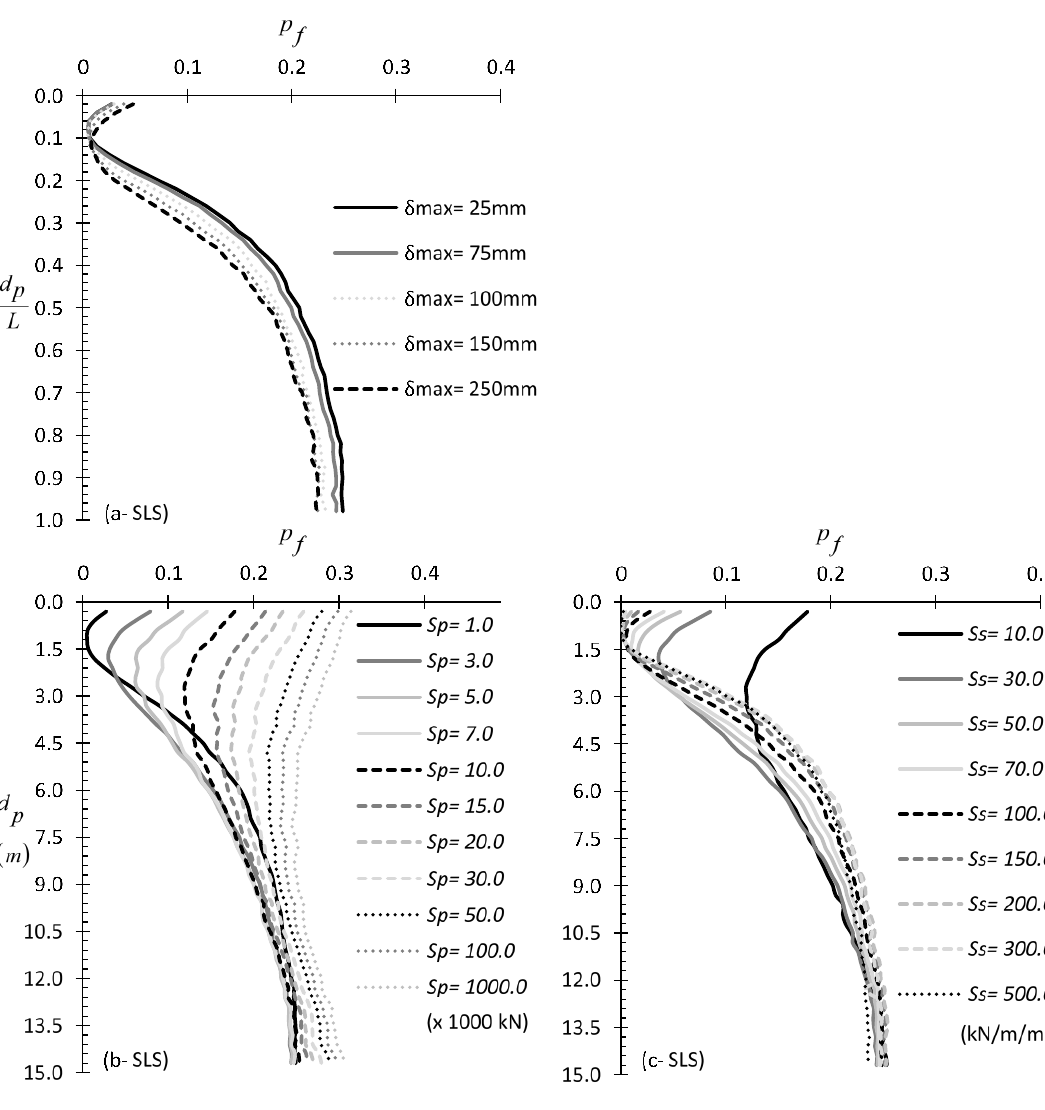
Figure 5. ( a ) p f vs. d p / L curves for the SLS state by considering di ff erent δ max values, ( b ) p f vs. d p d L curves for the SLS state by considering different Figure 5. ( a ) f p vs. p curves for di ff erent mean pile sti ff ness ( S p ) values for the SLS state, and ( c ) p f vs. d p curves for di ff erent d curves for different mean pile stiffness ( S ) values for the SLS state, and ( c ) vs. soil sti ff ness ( S s ) values for the SLS state; figures refer to scaled correlation length θ / L = 2 / p p   S values for the SLS state; figures refer to scaled correlation curves for different soil stiffness s length L   2/3.